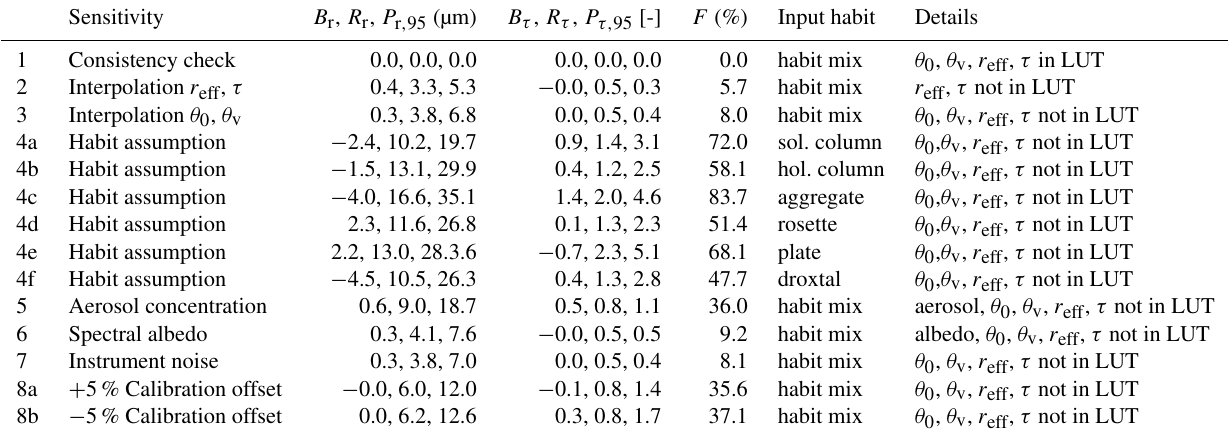
Table 1. Results of sensitivity studies: retrieval bias ( B r , B τ ), root mean square error ( R r , R τ ), 95 error percentile ( P r , 95 , P τ, 95 ), false detection rate F , habit of simulated test cases and details about chosen test cases. Optical thickness of tested cases is 0.3–17 and effective radius is 8–70